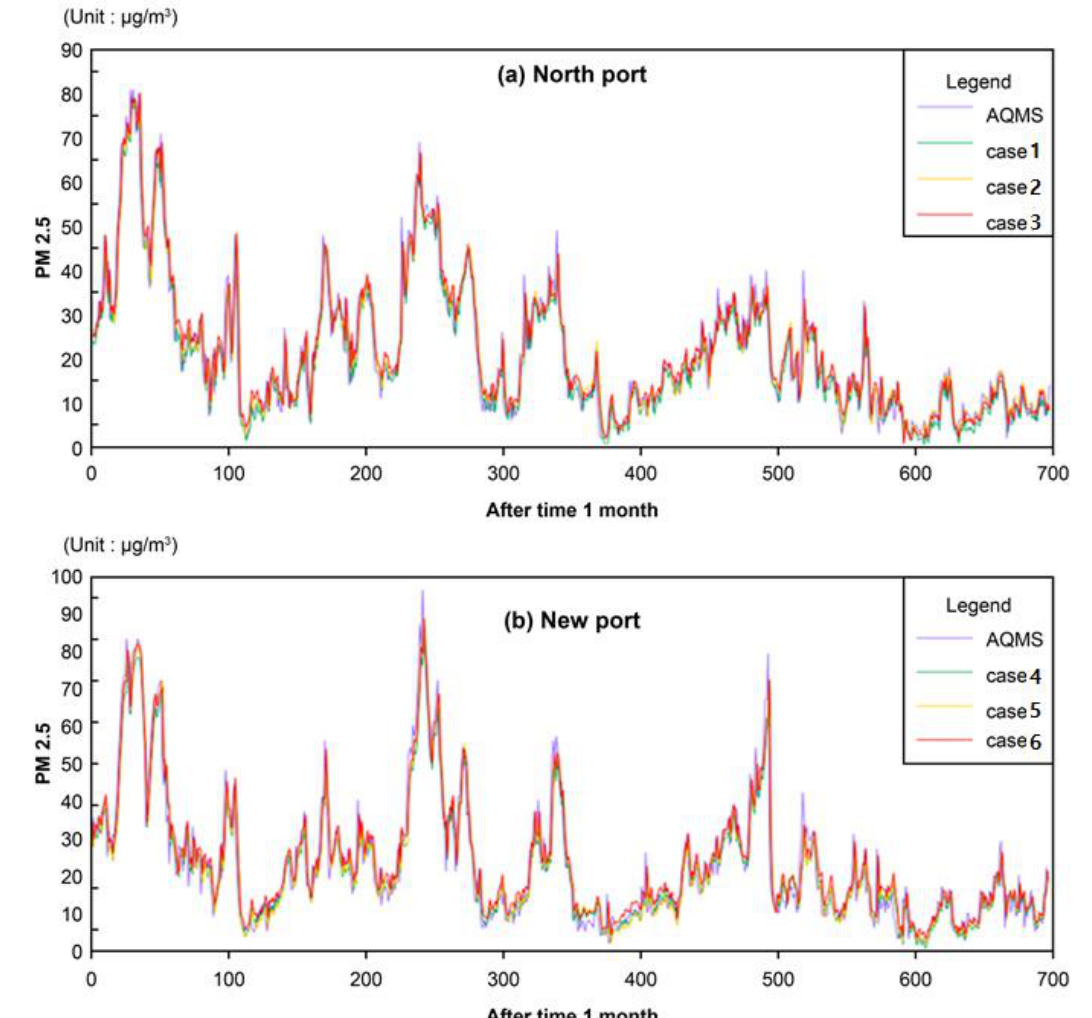
Figure 3. Comparisons between the ( a ) North Port and ( b ) New Port RNN-LSTM-predicted and AQMS-observed PM 2.5 (Case 1, 4: AQMS + ASOS; Case 2, 5: AQMS + ASOS + all anchored ships; Case 3, 6: AQMS + ASOS + anchored ships over 2000 tons).